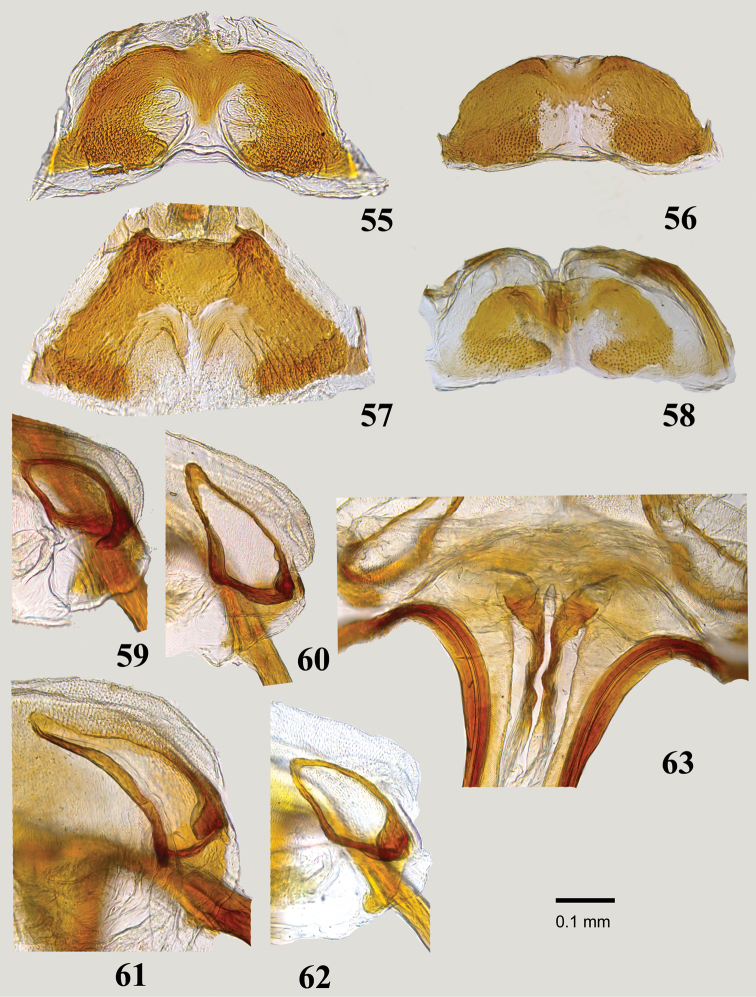
Female genitalia: 55–58 Posterior wall of bursa copulatrix 55Myrmecophyesarmeniacus Drapolyuk, 1989 56Myrmecophyesheterocerus Horváth, 1927 57Myrmecophyesnasutus Drapolyuk, 1989 58Myrmecophyestomi sp. n. 59–62 Sclerotized rings of dorsal labiate plate 59M.armeniacus60M.heterocerus61Myrmecophyesnasutus62M.tomi sp. n. 63 Vulva of M.heterocerus.